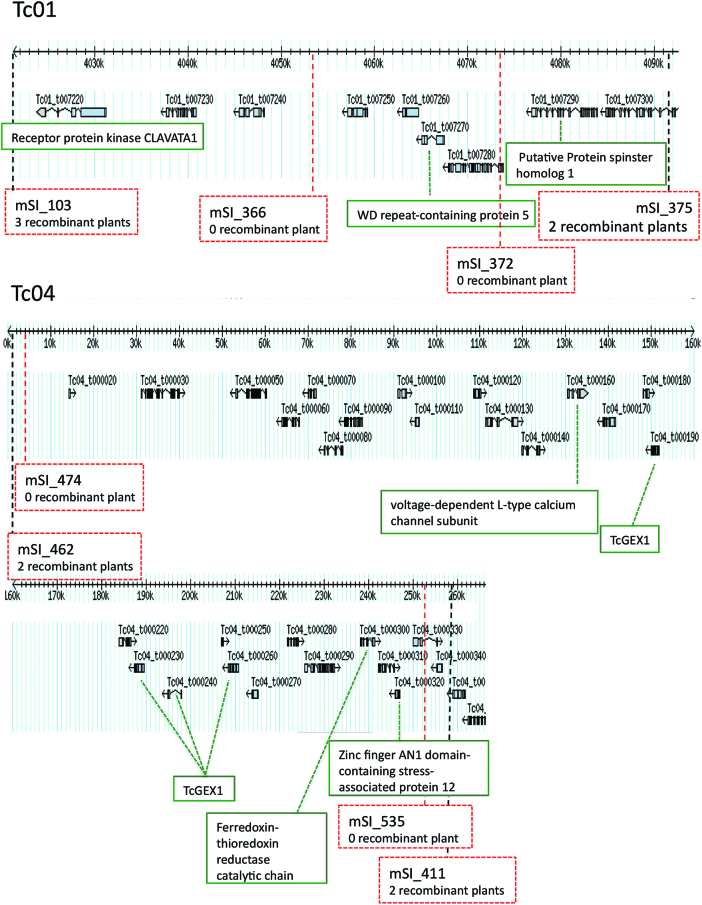
Schematic representation of CH1 and CH4 regions without recombinant plants. The SSR markers (mSI_x) delimiting the genomic regions of CH1 and CH4 without recombinant plants in the F2 progeny (with a total absence of one F2 genotype) are indicated in this diagram, as extracted from the cacao genome browser V1 (http://cocoa-genome-hub.southgreen.fr/gbrowse), as well as the candidate genes identified in these regions.